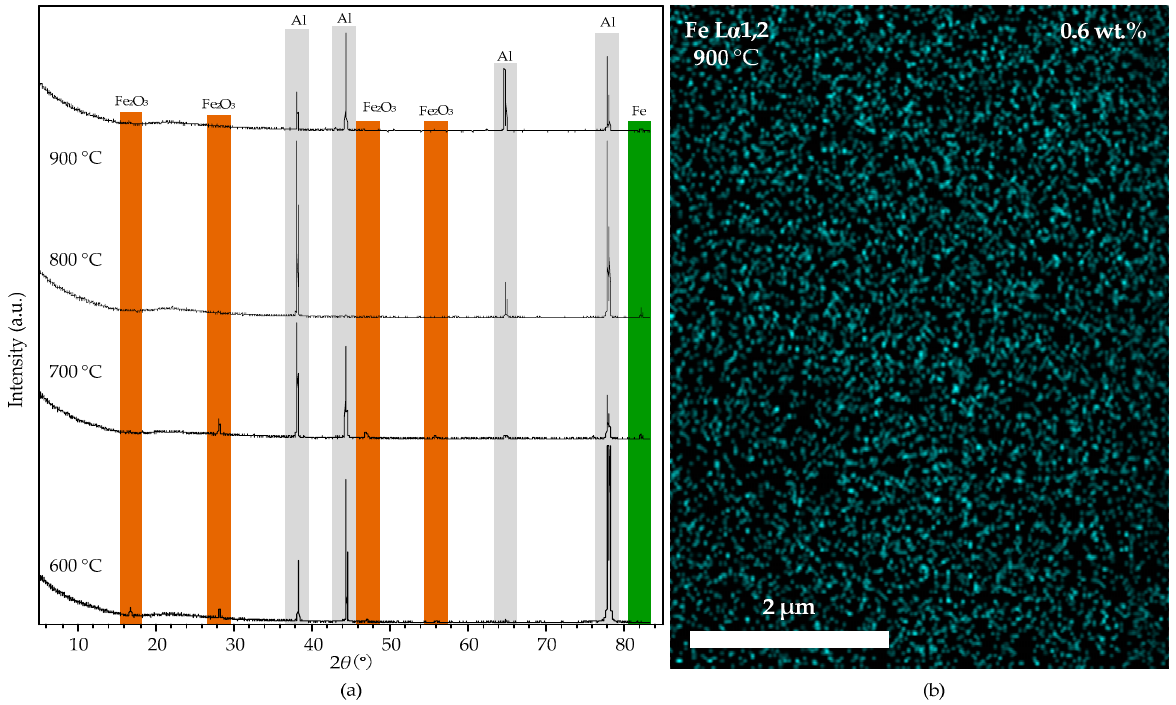
Figure 11. ( a ): the XRD spectra of the aluminum foil with alumina film after the reduction process at 600, 700, 800, and 900 °C. ( b ): the EDS mapping micrograph of the substrate at 900 °C.